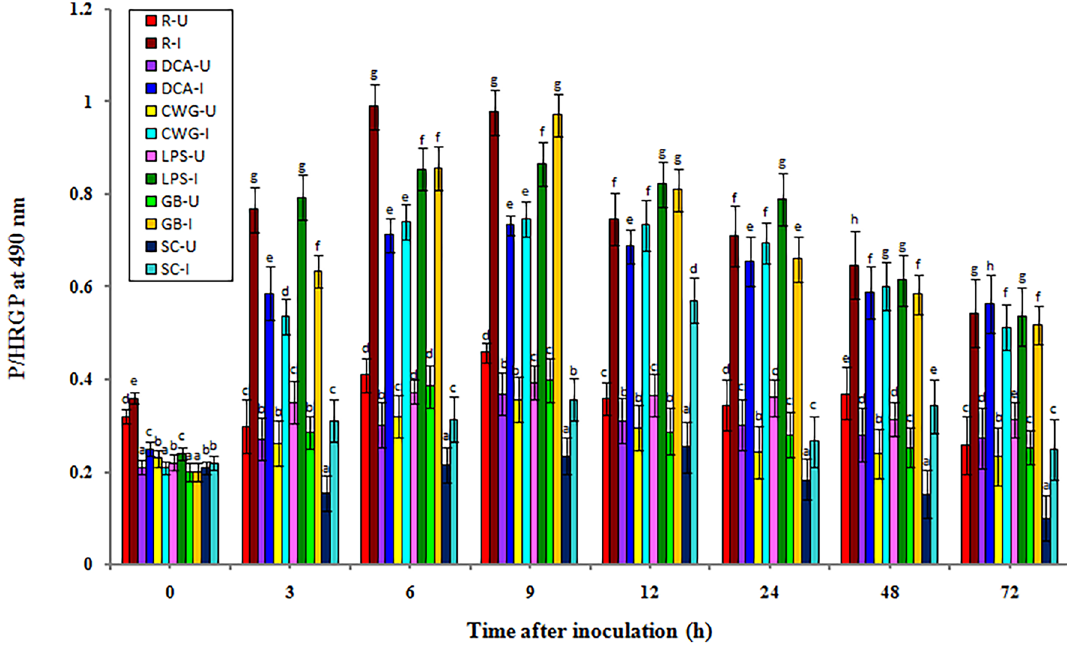
Figure 6. Temporal pattern of accumulation of HRGPs in 2-day old P. glaucum seedlings with (I-inoculated) or without (U-uninoculated) Sclerospora graminicola inoculation. R—resistant, S—susceptible, DCA—3,5- Dichloroanthranilic acid treated, CWG—Cell Wall Glucans isolated from the endophyte Trichoderma hamatum UOM 13, LPS—Lipopolysaccharides isolated from bacteria Pseudomonas fluorescens UOM 14, GB— Glycinebetaine an amino acid derivative. Bars indicate standard errors; means with different superscripts are significantly different, as shown by Tukey’s HSD test ( p ≤